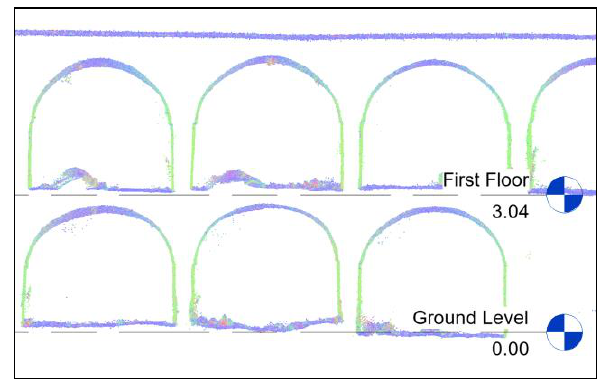
Figure 13. Vertical section of the west chambers of the